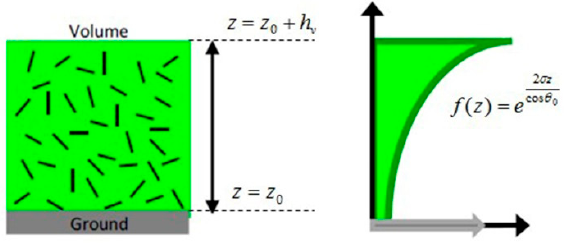
Figure 3. Two-layer physical model and its structure function representation [18].